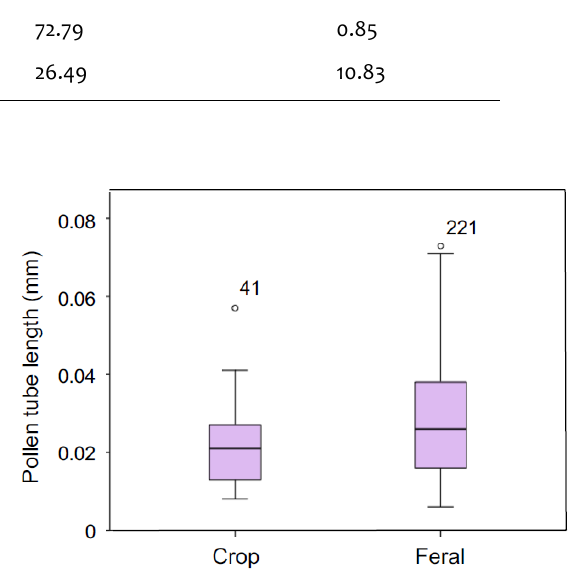
Figure 7. Box plot of pollen tube lengths after 3 h in crop and feral oilseed rape in the